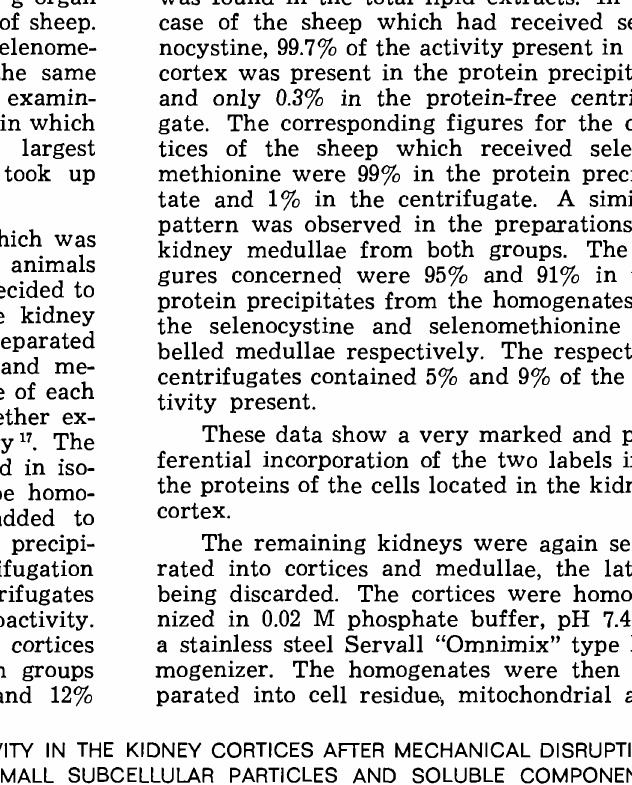
Table 3: DISTRIBUTION OF RADIOACTIVITY IN THE KIDNEY CORTICES AFTER MECHANICAL DISRUPTION AND CHEMICAL FRACTIONATION OF SMALL SUBCELLULAR PARTICLES AND SOLUBLE COMPONENTS Selenomethionine labelled